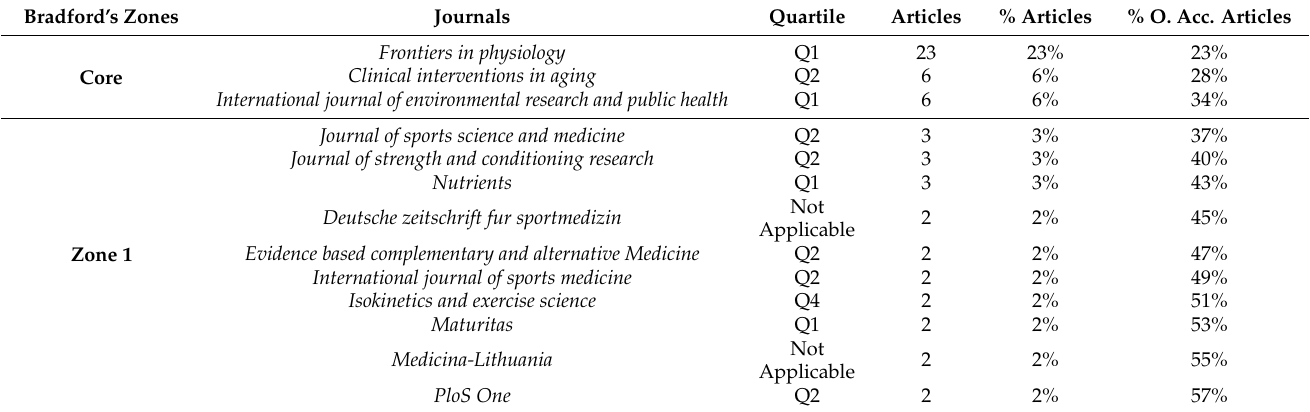
Table 1. Core and zone 1 (Bradford’s zones) journals, according to publications for WB-EMS.